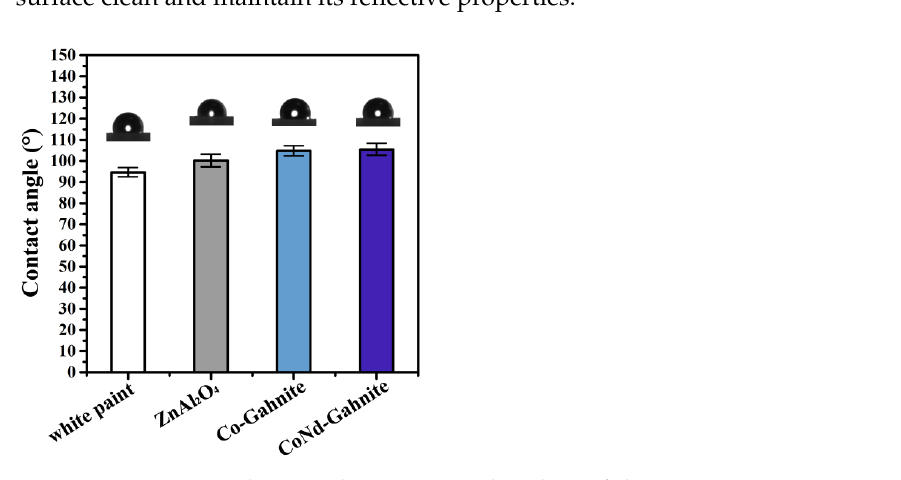
Figure 8 . Histogram showing the contact angle values of the pigment in coatings applied on a polycarbonate substrate.